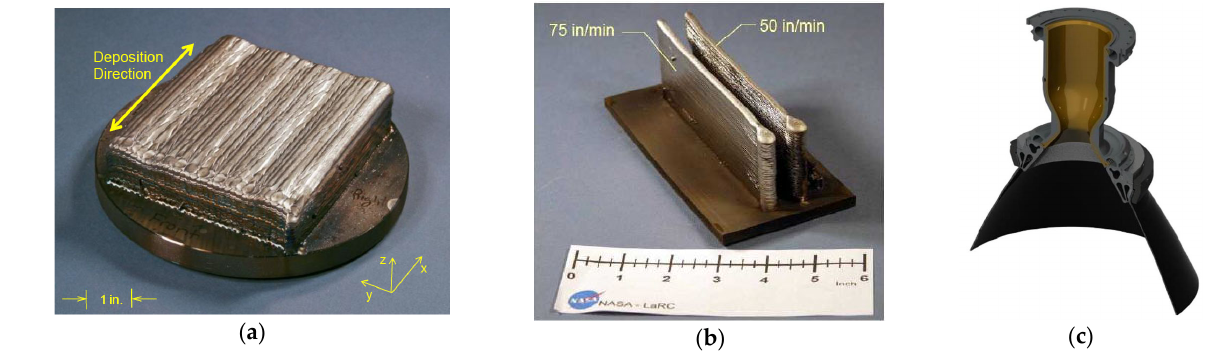
Figure 5. Geometry and shape of products made of heat ‐ resistant nickel alloys obtained by the EBAM method: ( a ) bulk [55], ( b ) thin ‐ walled [56], ( c ) complex geometry sample [57]. method: ( a ) bulk [55], ( b ) thin-walled [56], ( c ) complex geometry sample